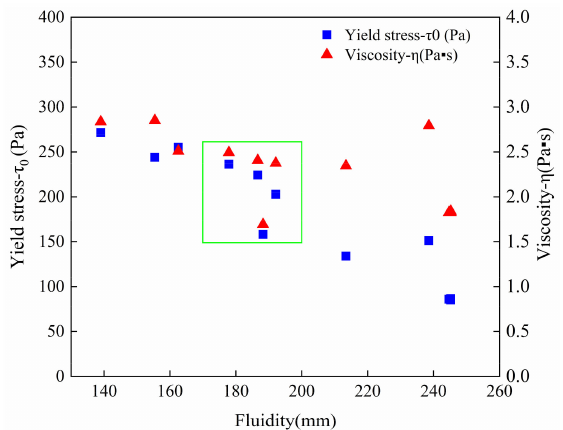
Figure 17. The printable window of yield stress, viscosity and fluidity.